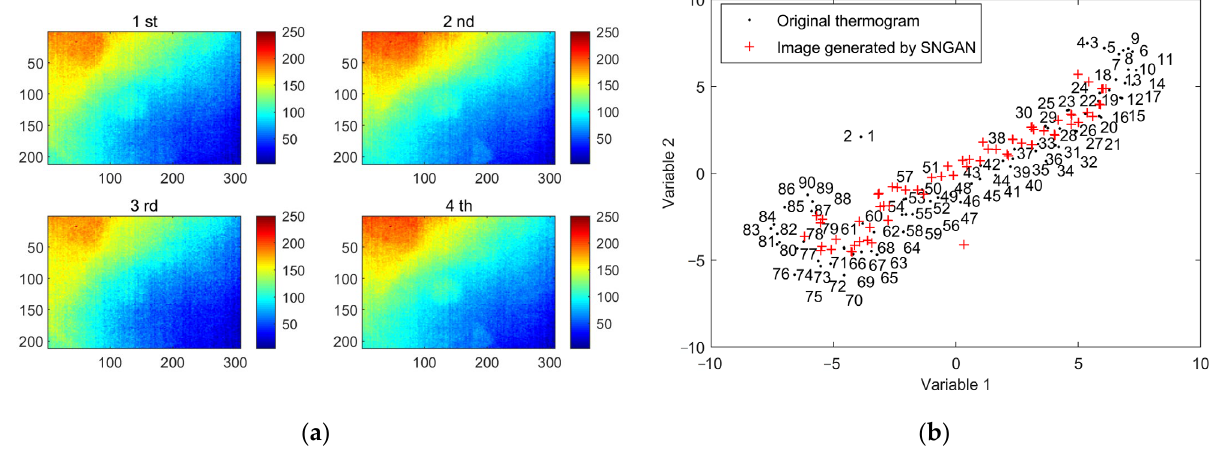
Figure 9. The SNGAN-generated thermal image data: ( a ) several simulated thermal images gener- ated by SNGAN; ( b ) t-SNE visualization of raw and generated data. by SNGAN; ( b ) t-SNE visualization of raw and generated